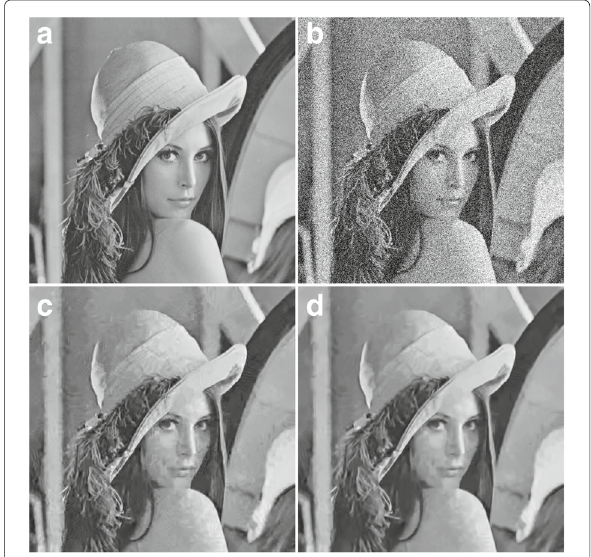
Fig. 4 Subjective assessment between the normal profile of BM3D and the proposed method. a Original image. b Noisy image at noise level σ = 50, PSNR = 14.60 and SSIM = 0.1163. c Output using the normal profile of BM3D, PSNR = 28.29 and SSIM = 0.7455. d Output using the proposed method, PSNR = 28.97 and SSIM =